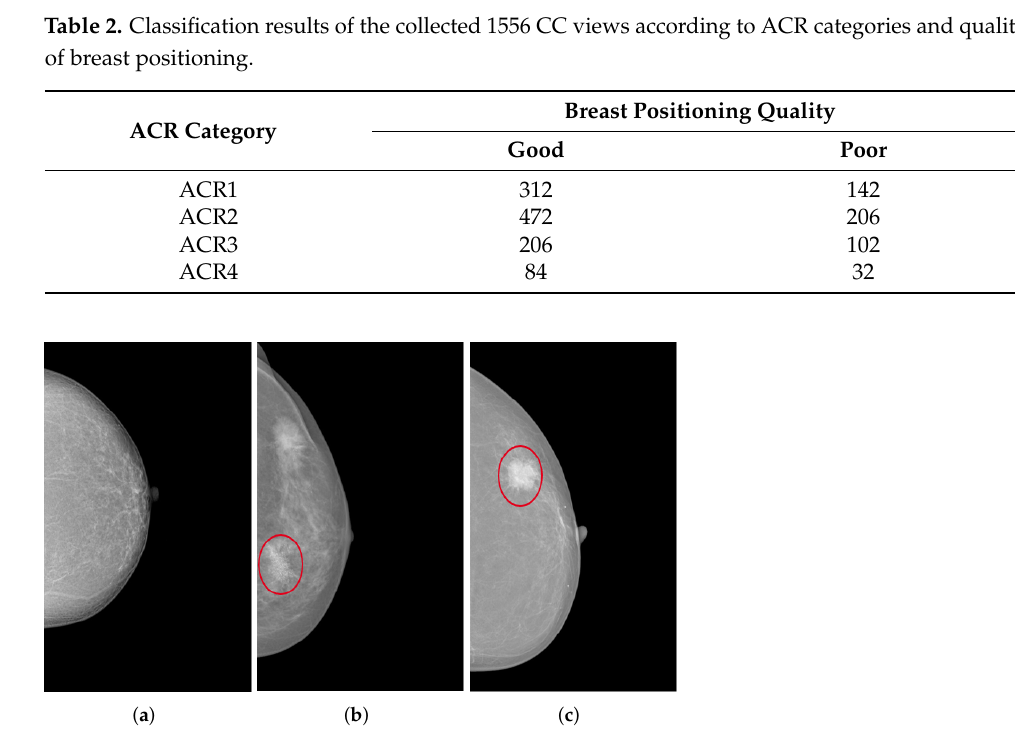
Figure 10. CC views of the left breast selected from the collected dataset: ( a ) shows no lesions, ( b ) shows fine and grouped microcalcifications in the inner lower quadrant of the breast (cf. red circle), and ( c ) illustrates a spiculated mass in the outer upper quadrant of the breast (cf. red